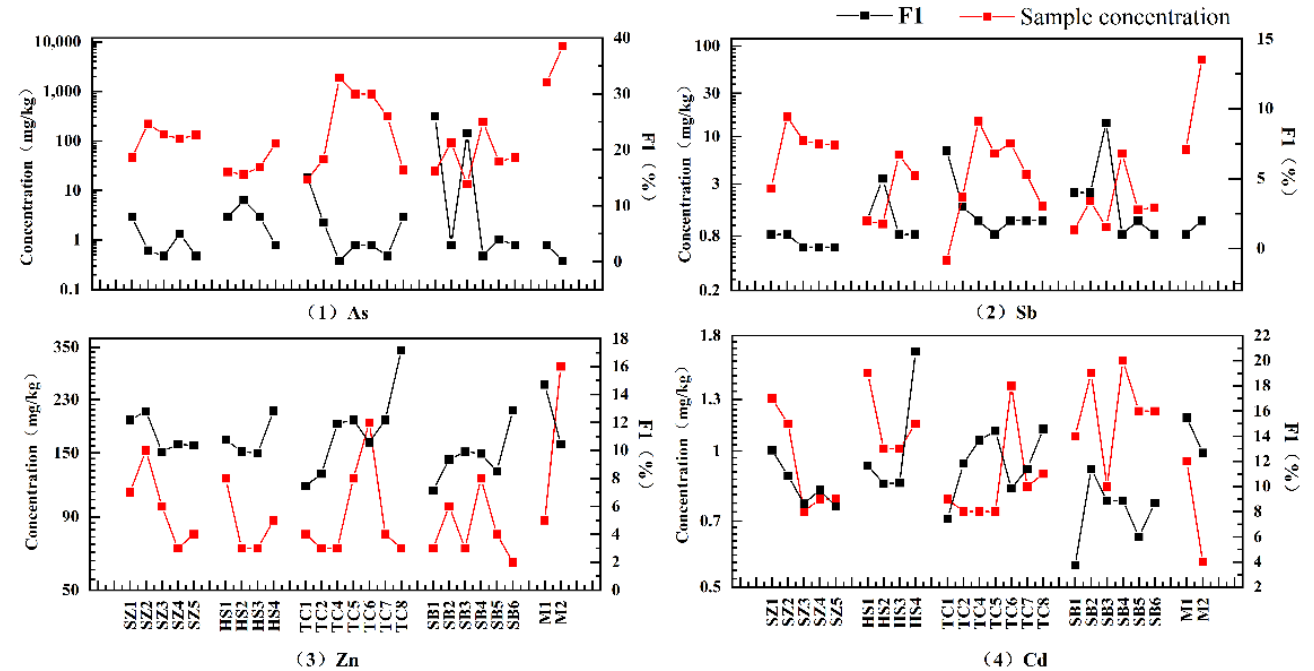
Figure 5. The changing relationship between the percentage change of F1 form and the total amount of As, Sb, Zn and Cd in